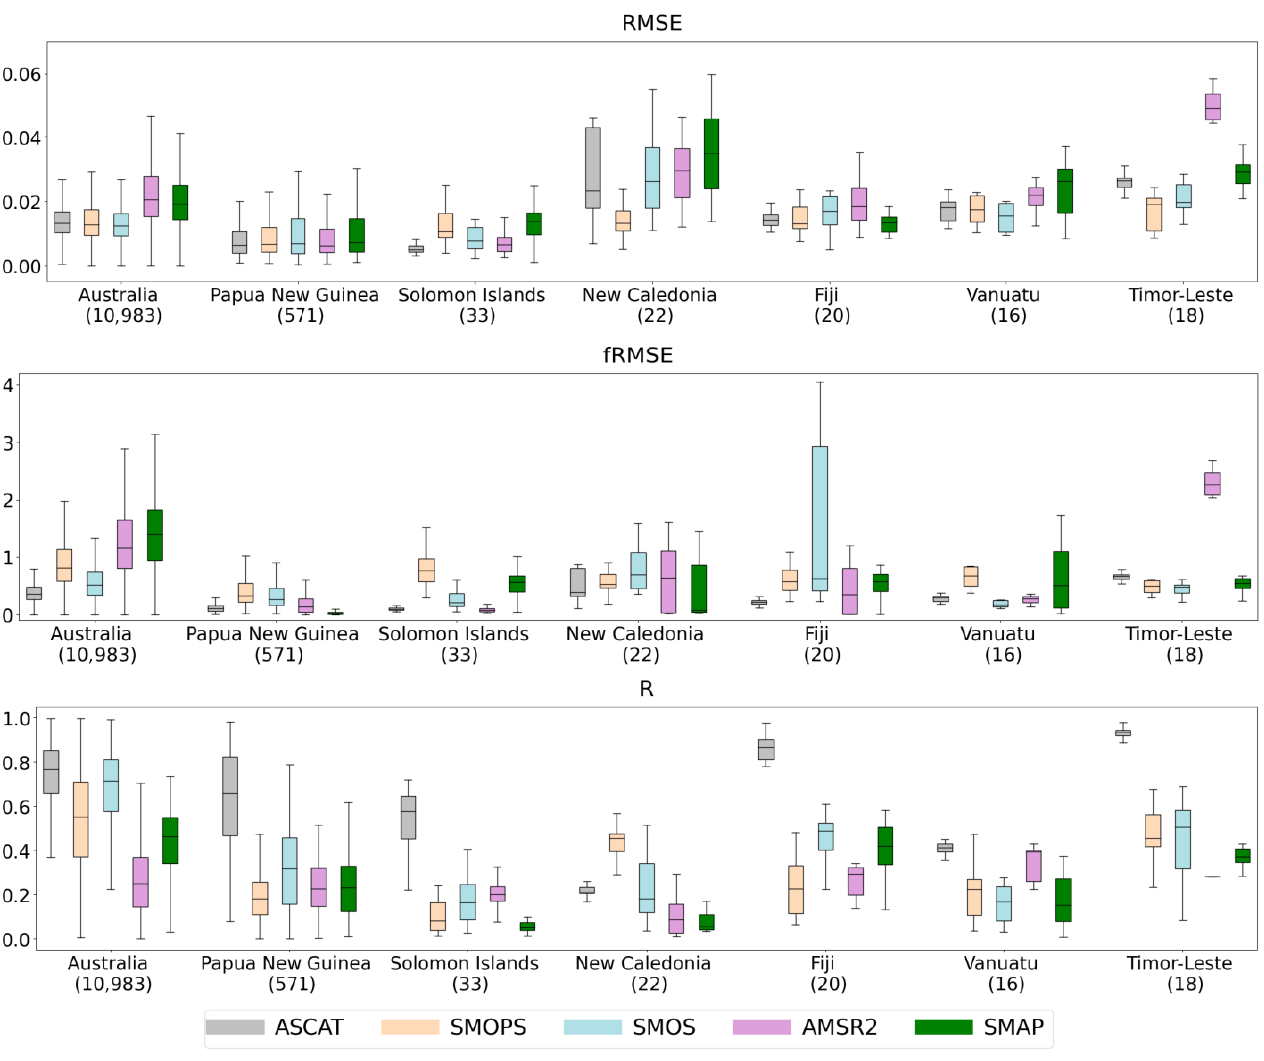
Figure 14. TC RMSE, fRMSE, and R categorized by country in the study domain — whiskers extend out to show the interquartile range, and the black bar indicates the median value of the distribution. N gridcells for each sub-domain are indicated in brackets — we caution the impact of sea water on coarse microwave SM land observations for these regions.